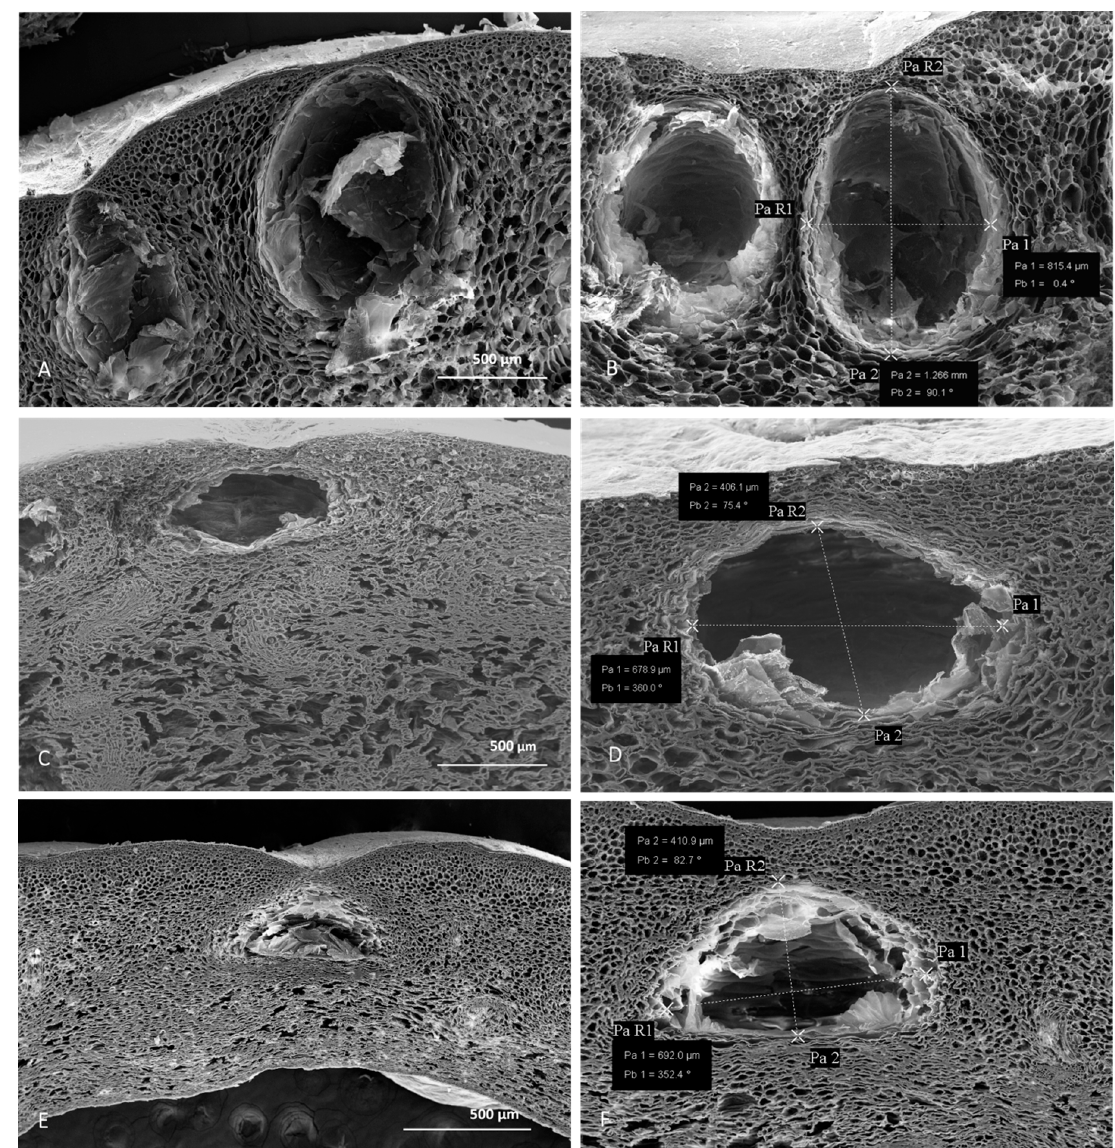
Figure 3. SEM micrographs of peel cross sections from C. lemon ( A , B ), C. × bergamia ( C , D ), and C. × mytifolia ( E , F ). Measures of the oil glands from the three different species are shown: lemon ( B ), bergamot ( D ) and chinotto ( F ). Table 1. Morphometric measurements of oil glands from the peel of C. limon, C. × bergamia and C. ×